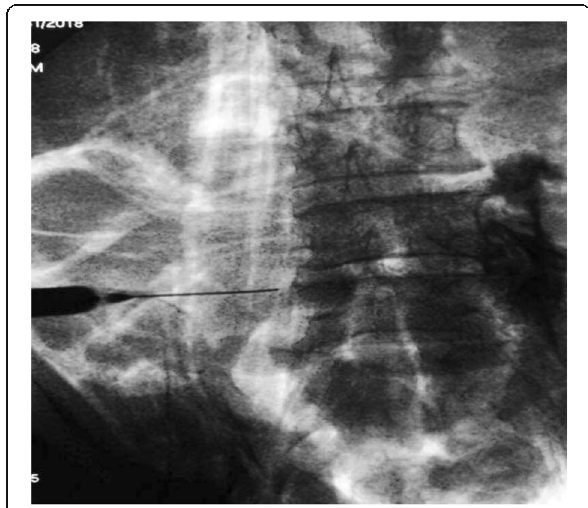
Fig. 4 A – P Fluoroscopic image of spinal needle approaching the desired intervertebral foramina and spinal dye spread